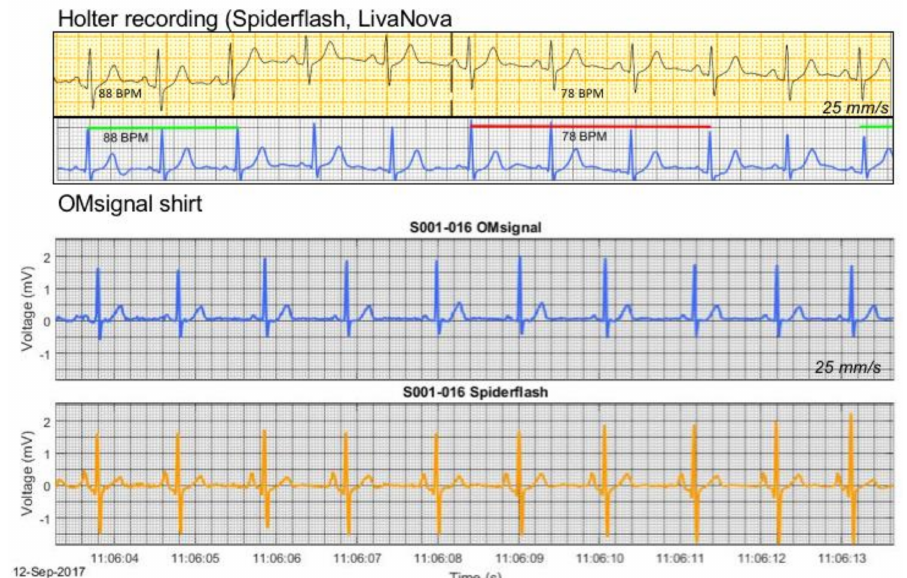
Figure 2. ECG samples of simultaneous recording with OMgarments and Holter. Shown are two samples of simultaneous recording with the OMgarment and a standard 3-lead Holter. The precise beat-to-beat signal coverage of the OMgarment allows even detection of subtle rhythm phenomena, such as respiratory sinus arrhythmia. Note the perfect signal overlay between Holter and garment and high signal quality of the ECG tracings from the OMgarments. The displayed ECG tracings from the OMgarment represent unfiltered signals without additional modification to improve signal